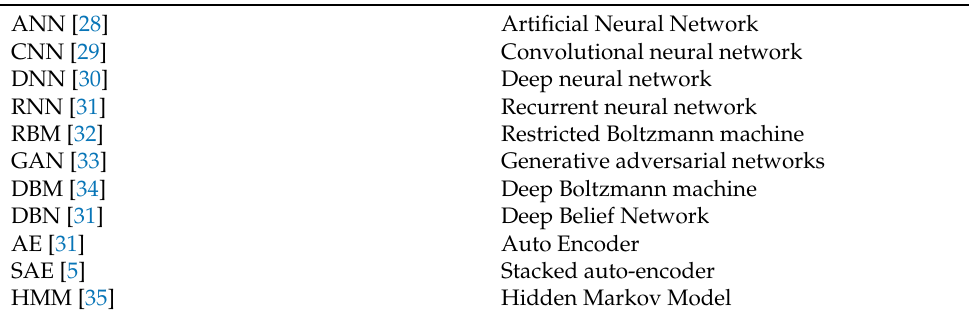
Table 1. Various kinds of DL methods.